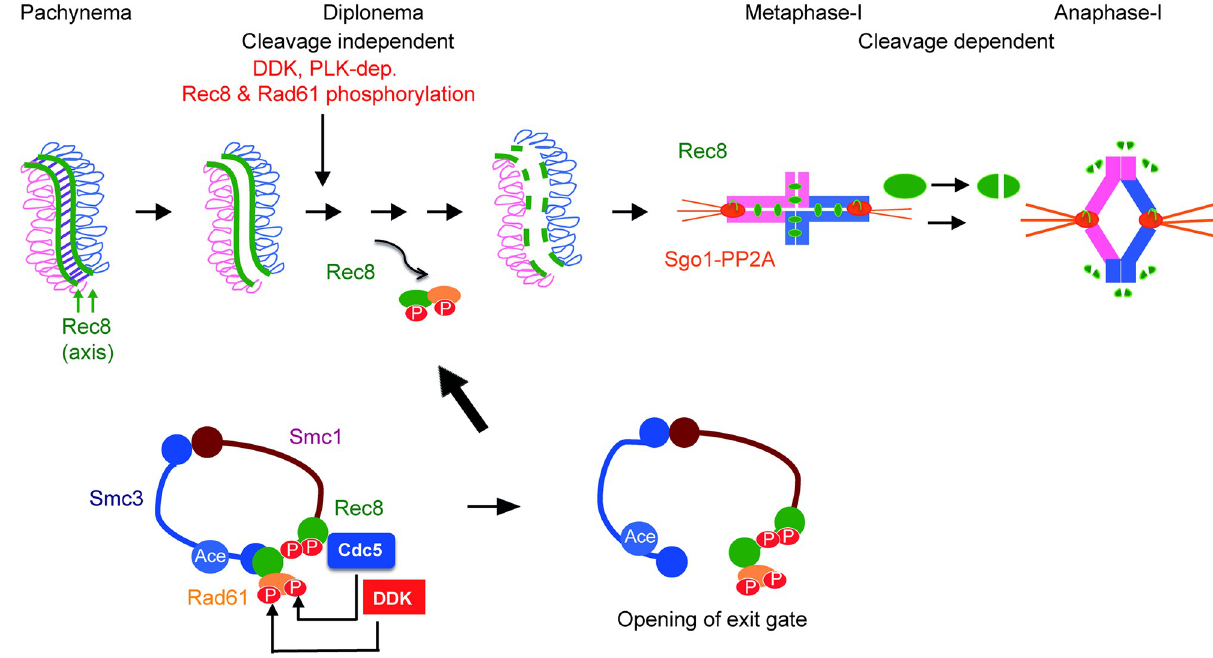
Fig 7. A model for meiotic prophase-like pathway at late prophase-I. Top, three step removal of cohesin during meiosis of the budding yeast. Bottom, possible model of cohesin release during late prophase-I by phosphorylation of Rec8 and Rad61, which may trigger the opening of the exit gate between Smc3 head and